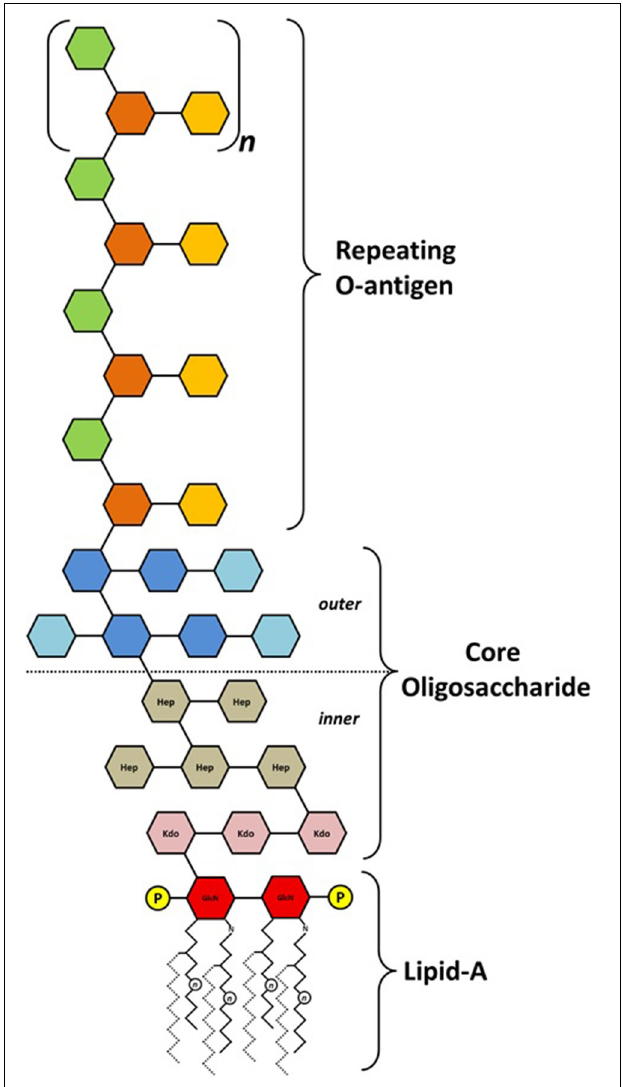
FIGURE 1 | Schematic representation of the general structure found on lipopolysaccharides. Fatty acid chain length ( n ) and position may vary greatly among different species (secondary fatty acids shown as dotted lines). Phosphate substitutions (P) are commonly found at C1 and C4 (cid:3) of both GlcN (2-amino-2-deoxy-D-glucose) units that form the lipid-A moiety. Phosphate substitutions may also be found attached to core or O-antigen units. Kdo (3-deoxy-D-manno-octulosonic acid) and Hep (D-glycero-D-mannoheptose) are most commonly found on the inner core structure, but other monosaccharides may